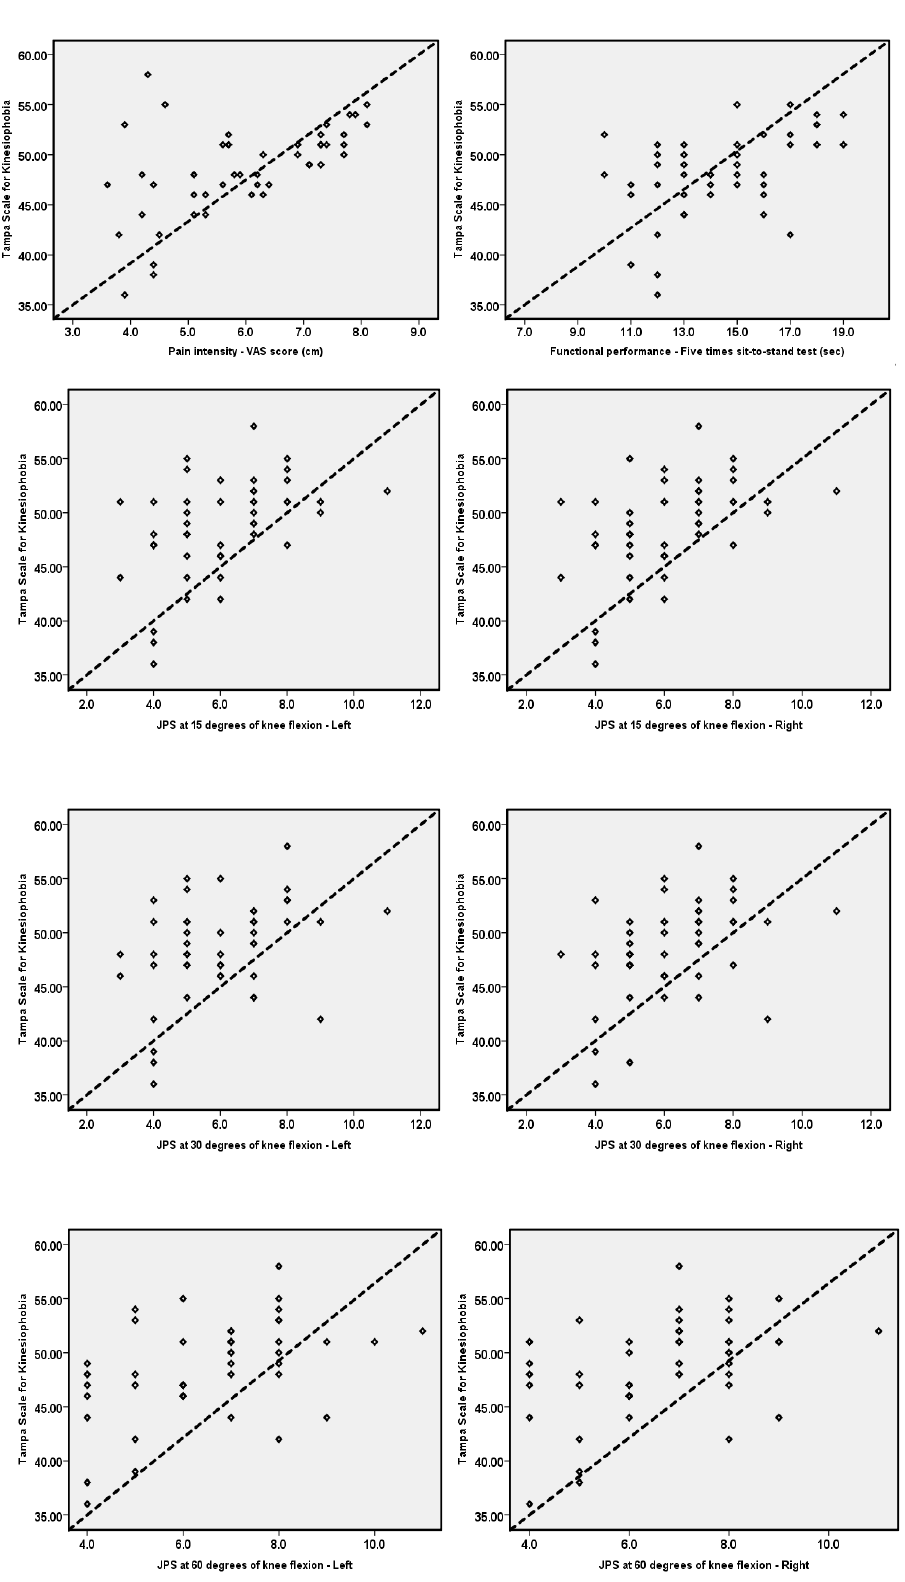
Figure 2. Association between kinesiophobia and pain intensity, functional performance, and JPS at target angles of 15º, 30º, and 60º for left and right sides. The results of Pearson correlation coefficients (r) showed a significant moderate pos- itive correlation between kinesiophobia and knee pain intensity (r = 0.55, p < 0.001). In addition, kinesiophobia showed a significant positive moderate association with knee JPS at the target angles of 15°, 30°, and 60° ( p < 0.05). The results indicate that an increase in kinesiophobia increases knee joint position errors. The most significant association was between kinesiophobia and right knee JPS at 15º of flexion (r = 0.50, p < 0.001). Also, there was a moderate positive association between kinesiophobia and functional performance (r = 0.49, p < 0.001). The kinesiophobia significantly predicted knee pain intensity (B = 1.05, p < 0.001), knee JPS (B ranged between 0.96 (30° of knee flexion for right side) and 1.30 (15° of knee flexion for right side)), and functional performance (B = 0.57, p < 0.001). Table 3 summa- rizes the results of the linear regression study.